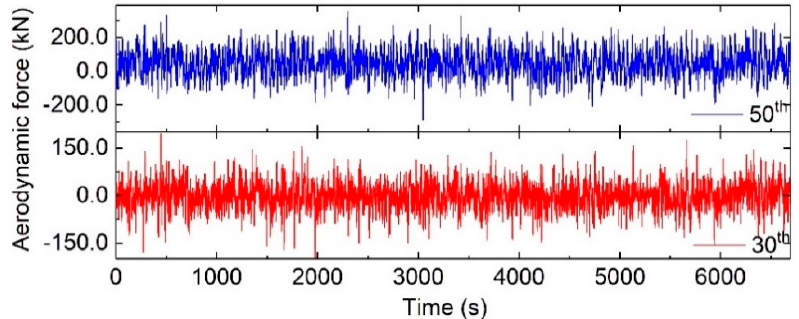
Figure 6. Time histories of aerodynamic forces on typical stories corresponding to 90° wind direction.